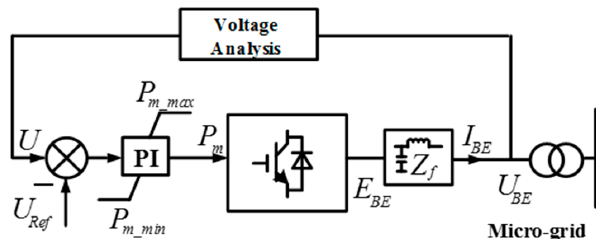
Figure 5. General voltage ‐ frequency (V ‐ F) control block diagram for the energy storage connected to the micro ‐ grid.